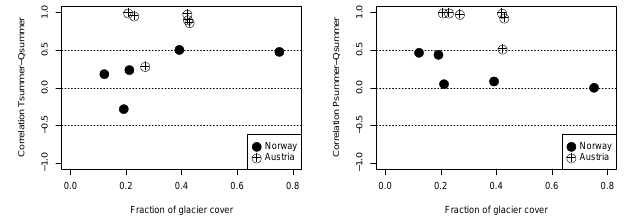
Figure 8. Correlation between Q summer and T summer and P summer for glaciermelt drought events in Austrian and Norwegian catchments in relation to fraction of glacier cover per catchment.